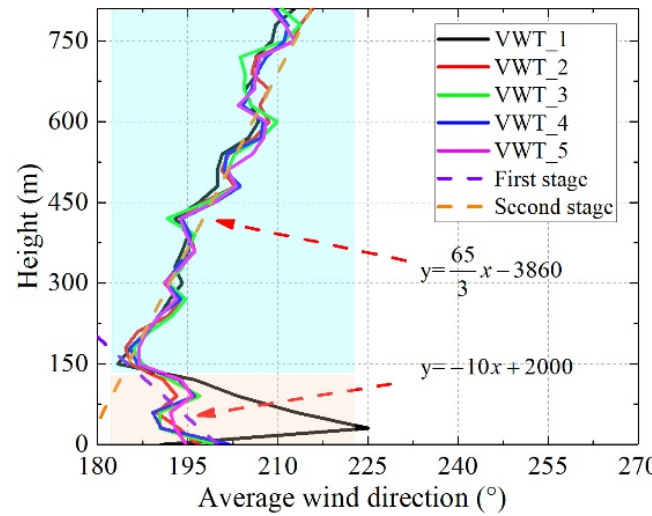
Figure 18. The law of wind direction changes with height.